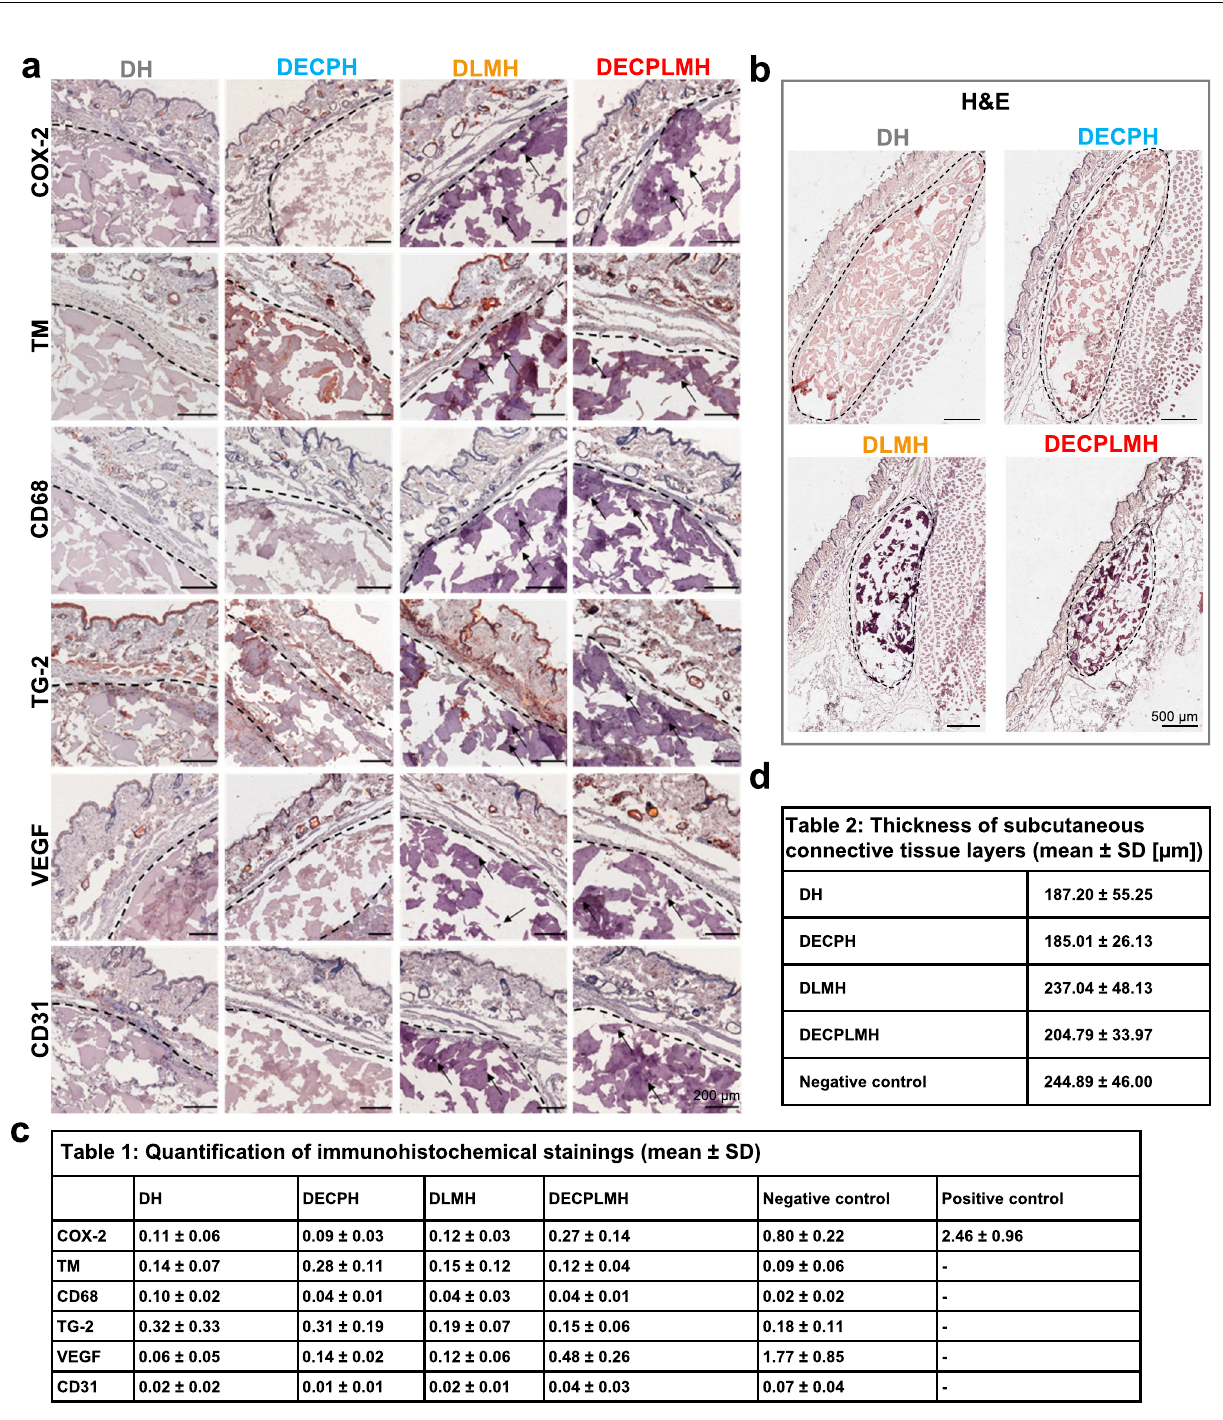
Fig. 9 In vivo hydrogel biocompatibility. a Representative immunohistochemical images of markers for in fl ammation (COX-2, thrombomodulin TM), pan- macrophages (CD68), matrix remodeling (TG-2), and angiogenesis (VEGF, CD31), cell nuclei in blue and positive immunohistological staining in red. The black line indicates hydrogel – tissue interface and arrows point on liquid metal nanoparticles. Immunohistological stainings of three animals per group were conducted and one representative image of each group is shown. b Representative histological images of H&E staining. Three animals per group were conducted with H&E staining and one representative image of each group is shown. c Quanti fi cation of immunohistochemical stainings (positive stained area related to cell nuclei area) ( n = 3 independent animals, mean ± SD). d Thickness of subcutaneous connective tissue layers based on Van Giesons ’ s staining compared to negative (untreated) control ( n = 3 independent animals, mean ±